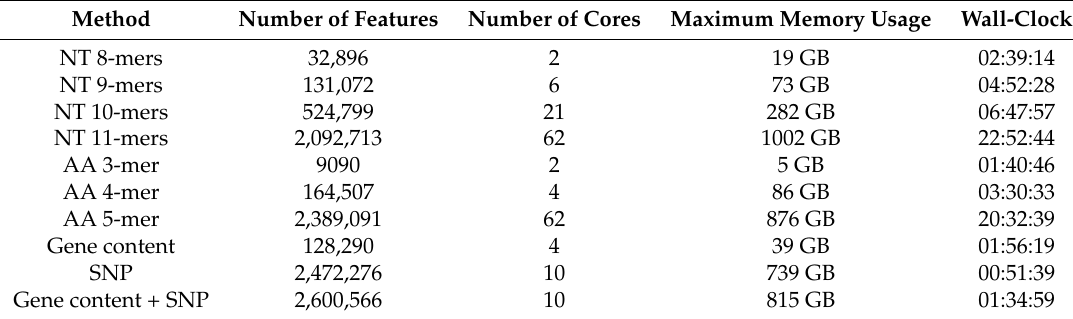
Table A70. Resources for S. enterica